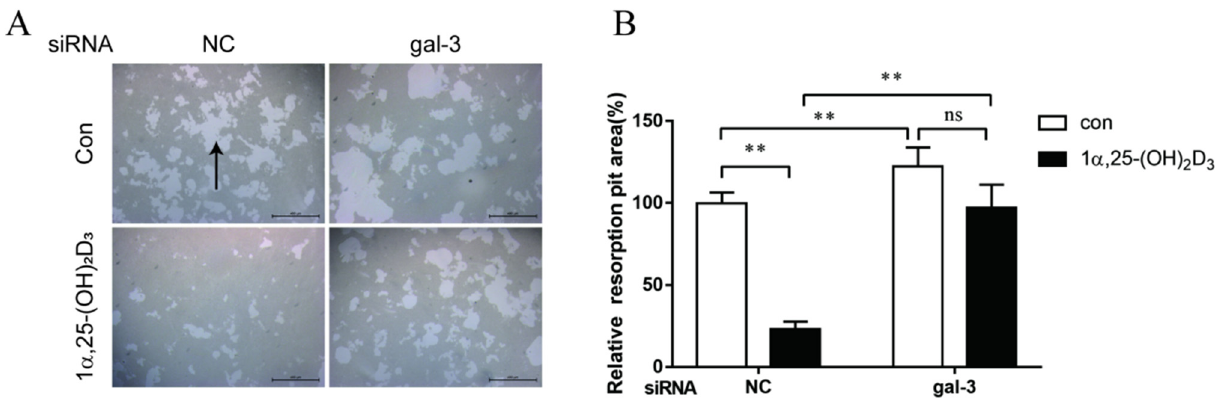
Figure 9. Gal-3 knockdown attenuated the inhibitory effect on bone resorption by 1 α ,25-(OH) 2 D 3 . ( A ) Bone resorption lacunae (marked by black arrows) observed by inverted microscopy. Bars = 400 µ m. ( B ) Statistical analysis of the area of bone resorption lacunae. Data are shown as means ± SD. n = 3, ** p < 0.01, ns means p > 0.05.